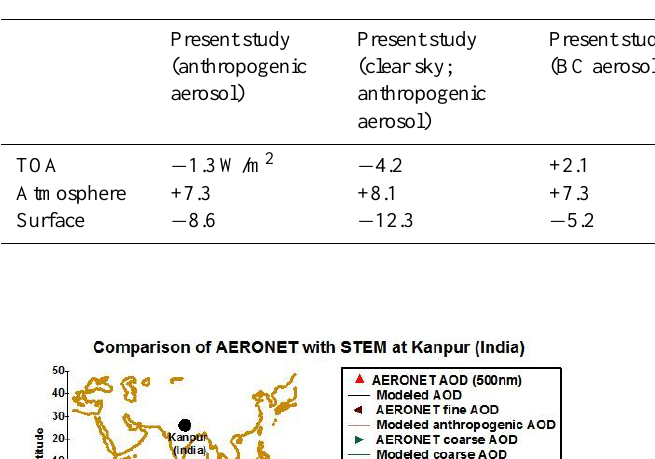
Table 1. Aerosol radiative forcing averaged in Asia (60–138 ◦ E and Equator–45 ◦ N). This table compares the present study’s calculations with those derived from Chung et al. (2005). Both studies used the MODIS and AERONET aerosol observations while the primary differences are i) aerosol vertical profile simulated by a high-resolution model in this study (as opposed to a prescribed uniform aerosol profile in Chung et al., 2005), ii) different aerosol-chemistry models used to fill up aerosol data gaps, and iii) different cloud observations.